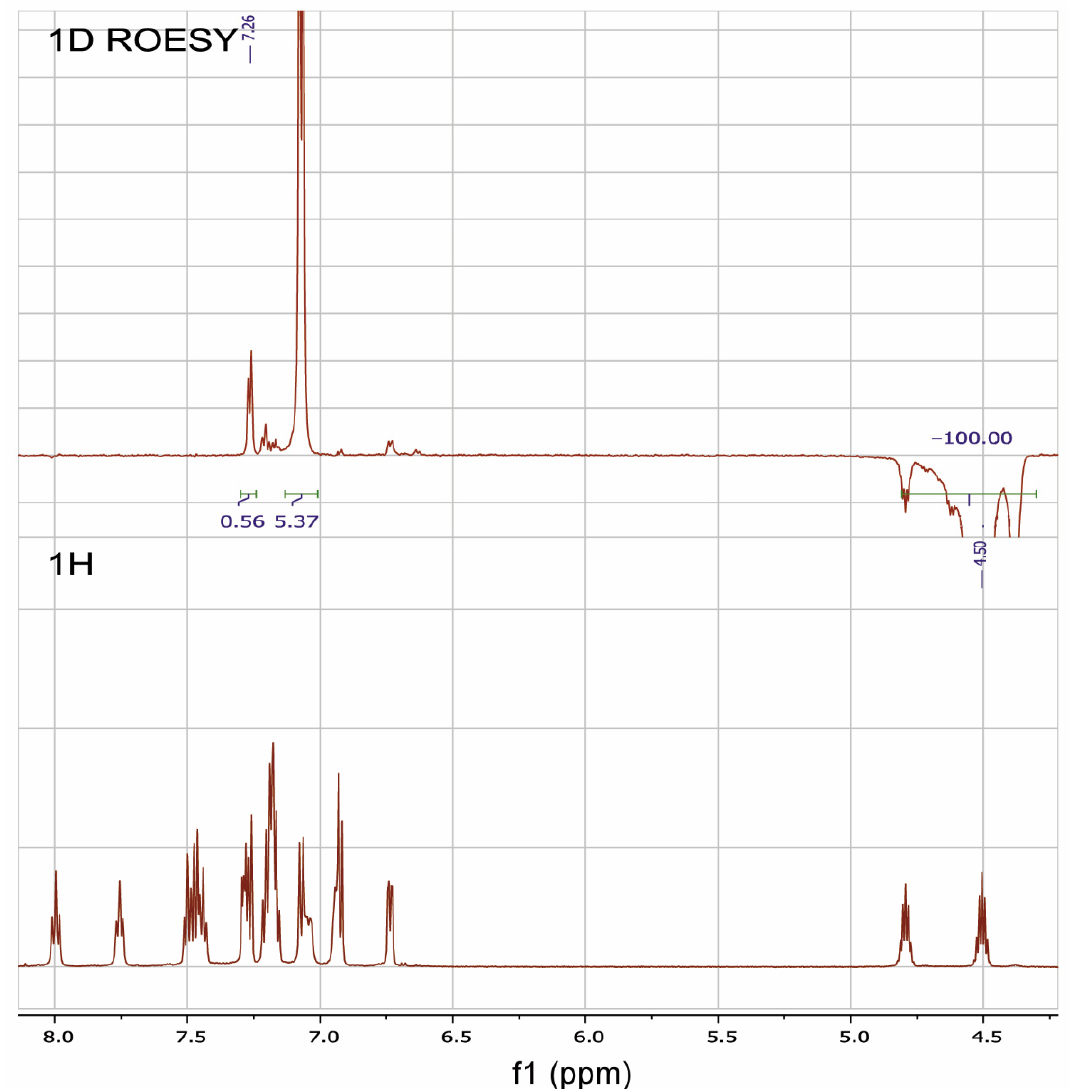
Figure 11. 1 H-NMR and 1D ROESY spectra of RuPhosPdG3 at saturating of the proton of one of the O- i -Pr groups at 4.50 ppm.